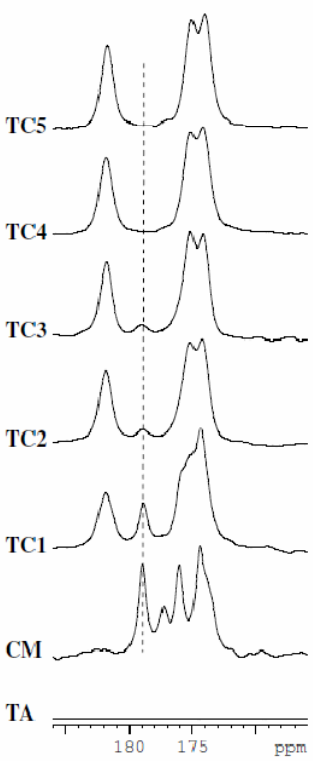
Figure 11. 13 C CP/MAS spectra of samples TA: Anhydrous Theophylline (has no peaks in this ppm range), CM: Citric acid monohydrate, TC1, TC2, TC3, TC4, and TC5 (sample descriptions are shown in Table 2). The extent of conversion to the cocrystal follows the order TC1 < TC3 < TC2 < TC4 =